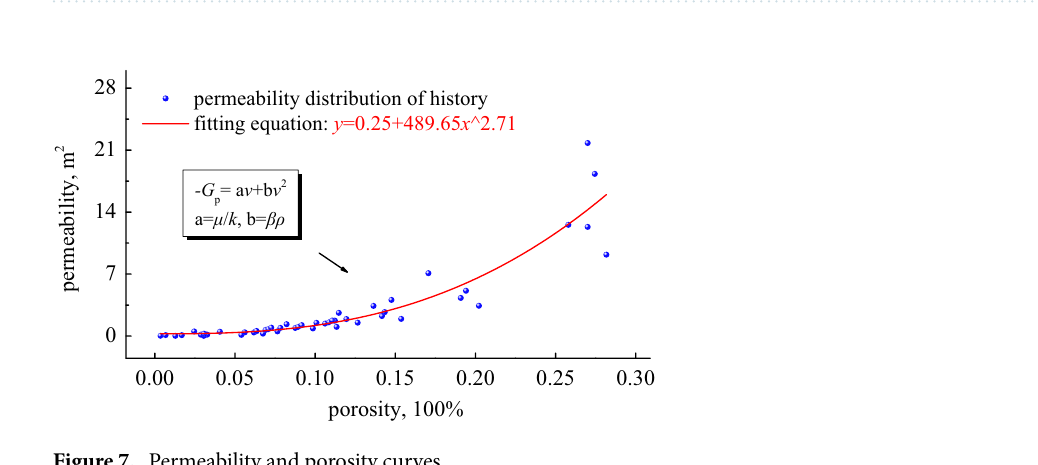
Figure 6. Non-Darcian factor and porosity curve.